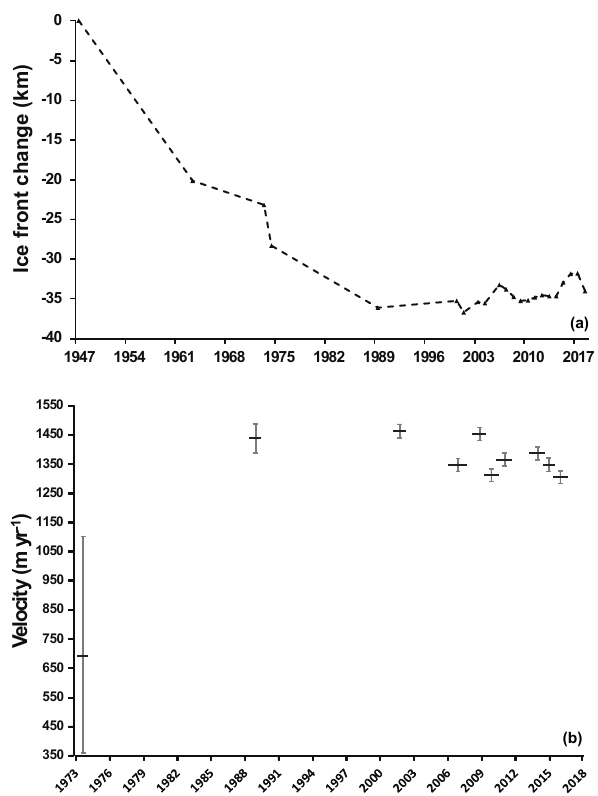
Figure 6. (a) Ice front position time series of Cook West between 1947 and 2018. (b) Velocity estimates and ice front retreat of Cook West Glacier between 1973 and 2017 based on feature tracking. The grey bars represent error. Note the increase in velocity between 1973–1974 and 1989 coincides with the retreat of the Cook West Ice